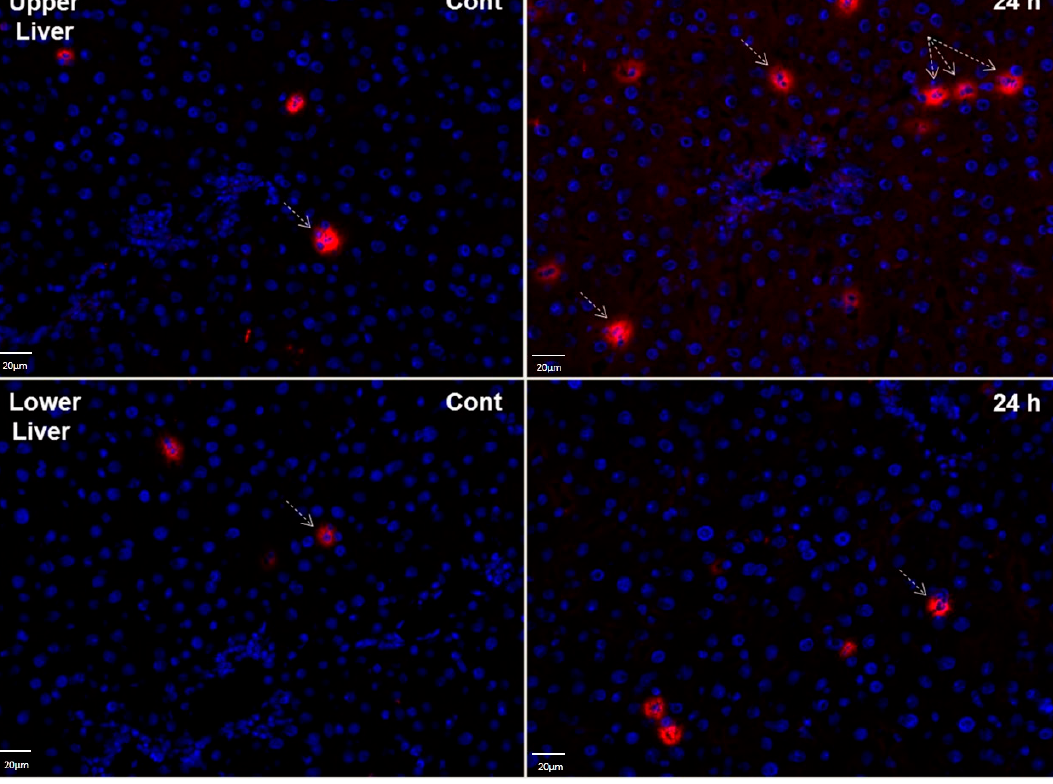
Figure 8. Immunofluorescence staining of LCN2 in tissue sections of upper and lower parts of the liver from sham irradiated control rats (Cont) and 24 h after irradiation. Sections were stained with anti-LCN2 (red, exemplary LCN2 positive cells are pointed out with arrows) followed by a fluorescence immunodetection. Counterstaining of the nuclei was done with DAPI (blue) (original magnification 200×).